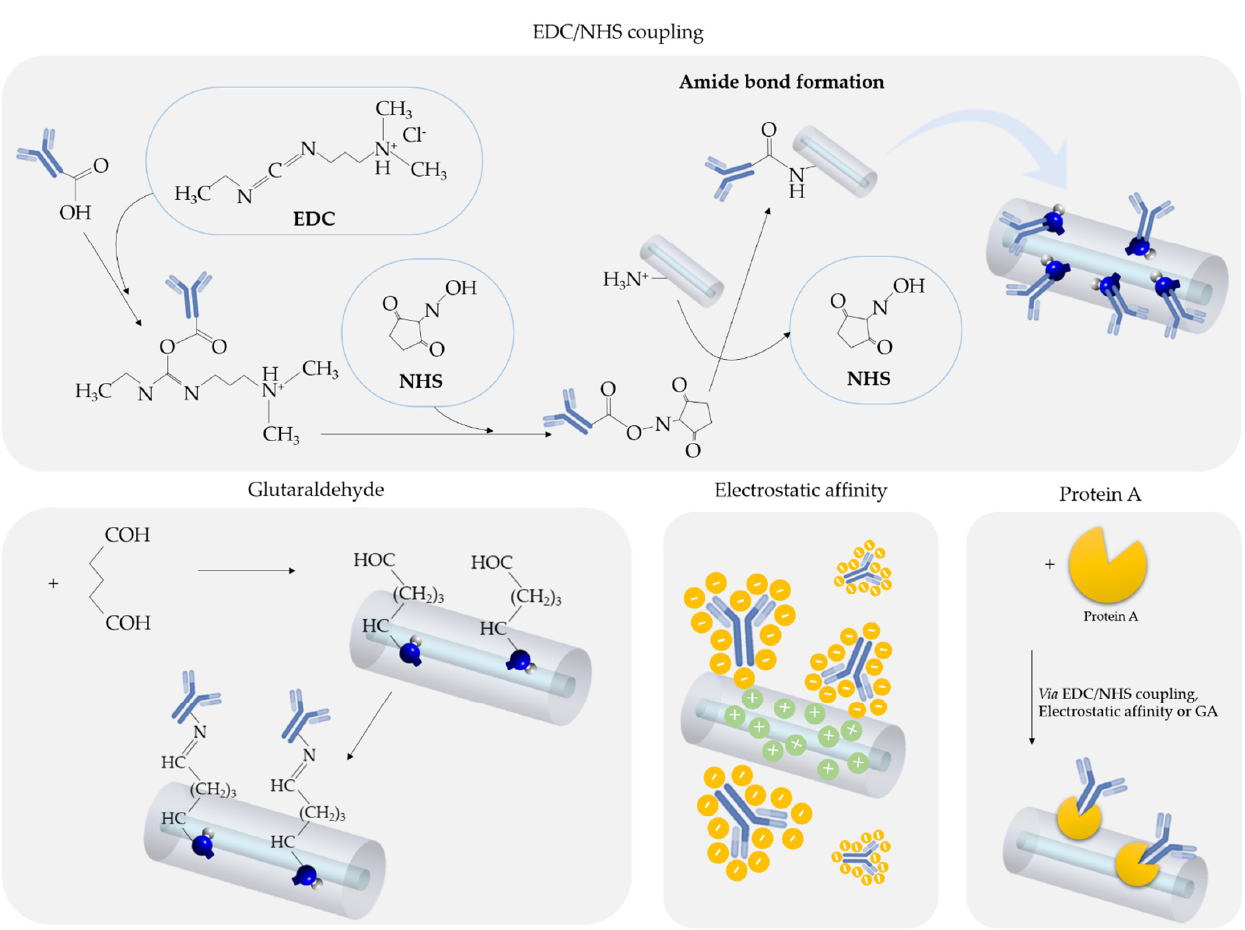
Figure 7. Schematic representation of antibody immobilization strategies: using EDC/NHS coupling or GA via electrostatic interaction or using Protein A.